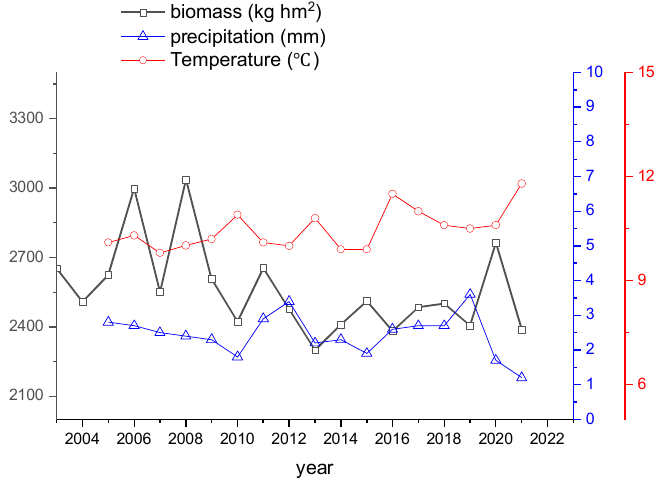
Figure 5. 2000–2021 Annual average scatter diagram of AGB in the Muli Figure 5. 2000 – 2021 Annual average scatter diagram of AGB in the Muli region.